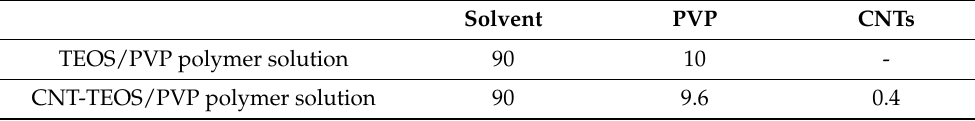
Table 3. Components proportion of polymer solution by weight percent